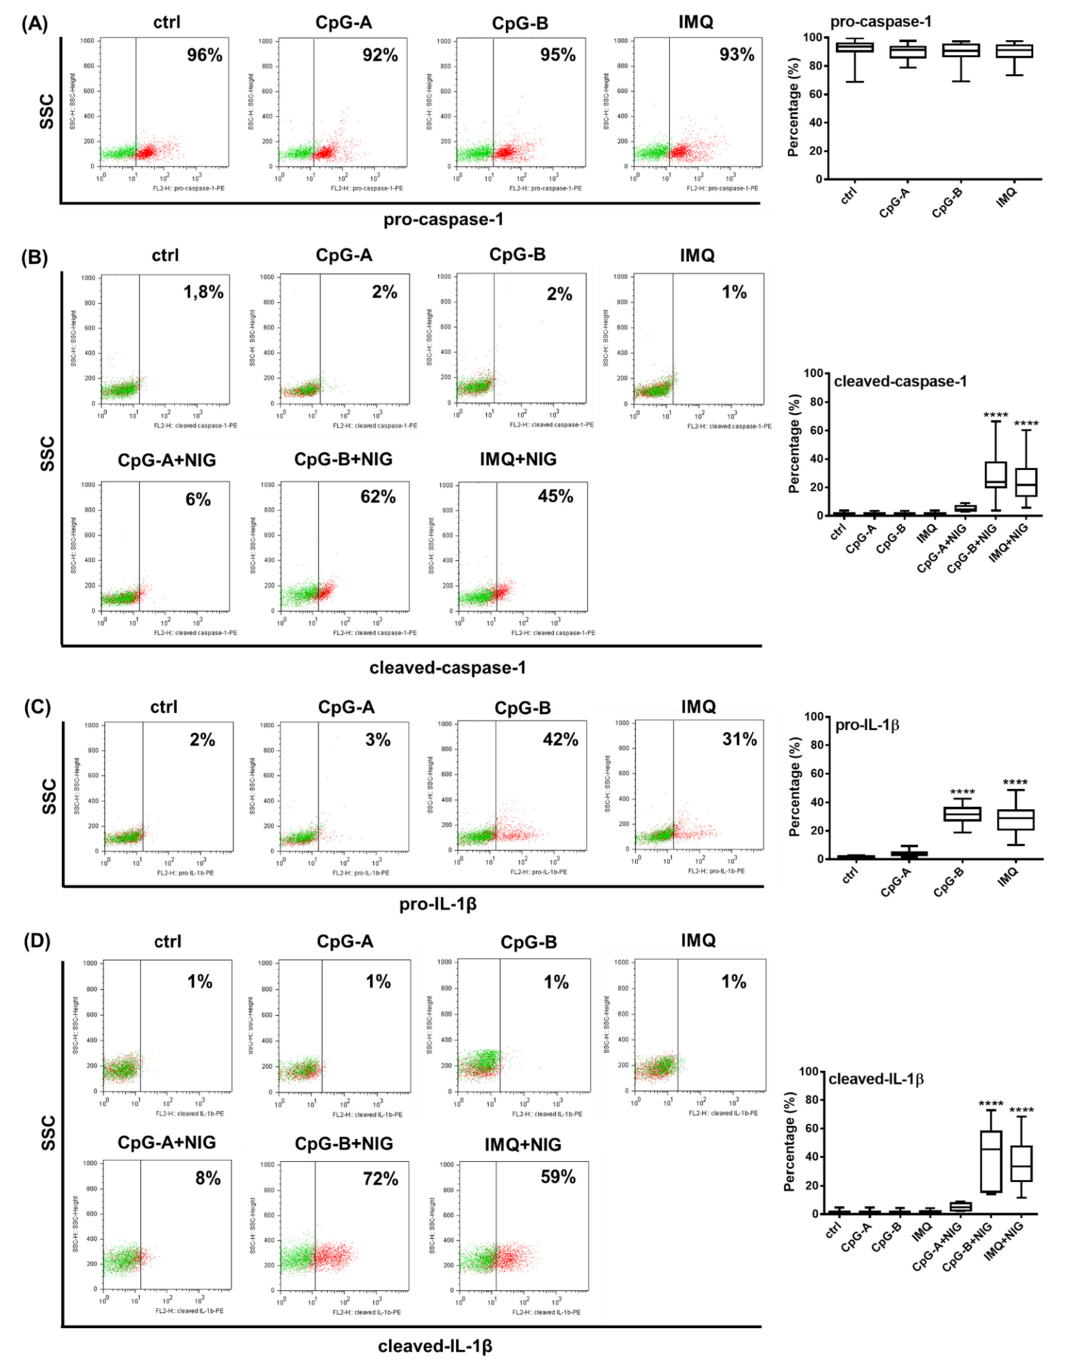
Figure 5. TLR ligands differ in their IL-1 β inducing capacity in primary human pDCs. PBMCs were separated from peripheral blood of healthy donors, then the cells were analyzed by flow cytometry for pDCs. PBMCs were primed with 1 µ M CpG-A or 1 µ M CpG-B or 5 µ g/mL IMQ for 2.5 h ( A – D ). In parallel, 20 µ M nigericin was applied for 1 h to induce the NLRP3-dependent cleavage of caspase-1 and IL-1 β , where it is indicated ( B , D ). The percentage of pro-caspase-1 ( A ), cleaved caspase-1 ( B ), pro-IL-1 β ( C ) and cleaved IL-1 β ( D ) -positive cells was determined within the pDC population using intracellular flow cytometry. Representative dot plots are shown in ( A – D ). Green dots indicate isotype controls and red dots show the specific proteins ( A – D ). Data are represented as means ± SD of 22 individual experiments and analyzed using one-way ANOVA followed by Bonferroni’s post-hoc test. **** p < 0.0001 vs. control (ctrl). IMQ: imiquimod, NIG: nigericin, SSC: side